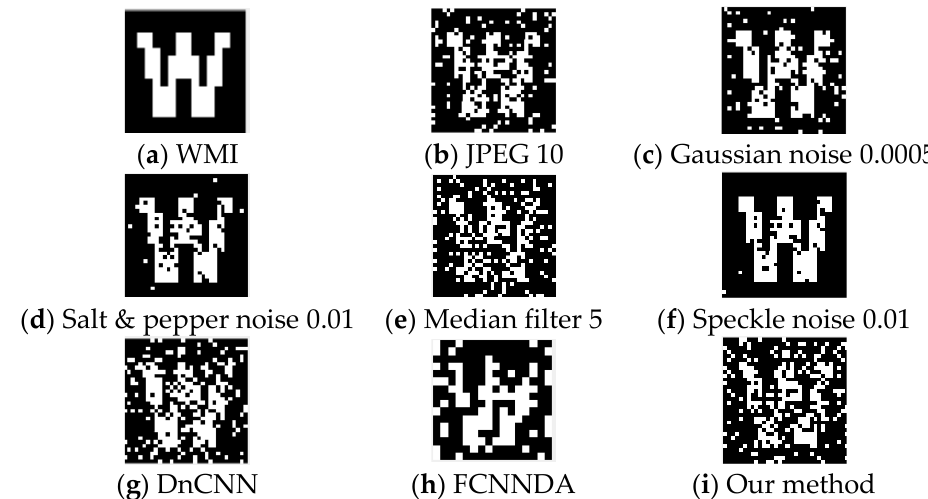
Figure 6. The image watermark extracted from the AWMI; the watermark size is 32 × 32.